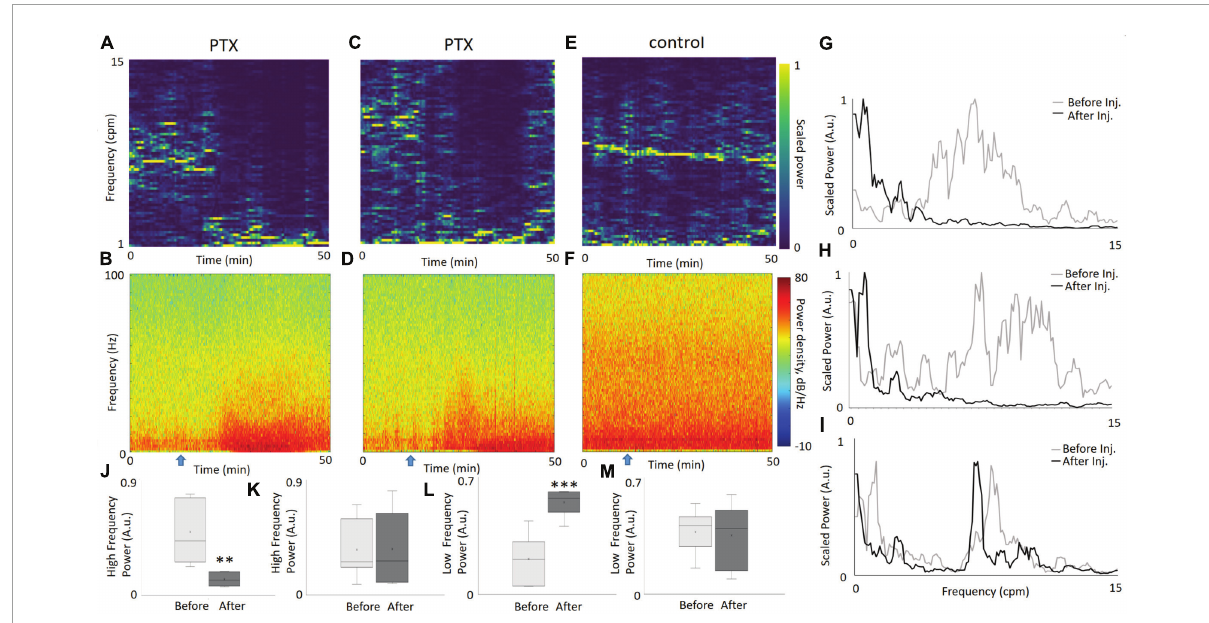
FIGURE2 The dynamics of PO 2 and LFP, before and after the injection of PTX. PO 2 spectrograms from two illustrative experiments (A,C) highlight the change of dominant frequencies from relatively fast (5–15 cpm) to slow ( < 5cpm) after injection of PTX at the 15 min mark (denoted by a blue arrow). An increase in the power of the delta LFP band, as seen in the LFP spectrograms (B,D) , following the injection. Meanwhile, both the PO 2 and LFP spectrogram for the saline experiment show no apparent change in dynamics [ (E,F) , respectively]. Comparing the power spectral density (PSD) of PO 2 from the first 10 min to a time window between 30 and 40 min, explicitly shows the disappearance of high frequency PO 2 fluctuations for the PTX experiments [ (G,H) , corresponding to (A,C) , respectively], unlike the saline experiment corresponding to panel (E) , which displays no visible change (I) . We measured the proportion of power within the PSD in the 5–15 cpm frequency (“high frequency”) range for periods before and after injection, over all our PTX experiments ( N = 7) and display the distribution as a whisker-bar plot (J) . A paired t -test confirmed that the difference in proportion of the high frequency component before and after injection is statistically significant ( p = 0.002). Similarly, for our saline experiments ( N = 7), there was no statistical difference before and after injection (K) , confirming the stability of a high frequency PO 2 oscillatory component in the control. We also compared the low frequency (1–2 cpm) amplitude relative to the total power for each time window, graphing a bar-whisker plot for our PTX data (L) and our saline data (M) . The differences in amplitude are statistically significant ( p = 0.0008) before and after injection for our PTX experiments, and not significant for our saline experiments. Two asterisks represent a significant difference p < 0.01. Three asterisks represent a significant difference p < 0.001.